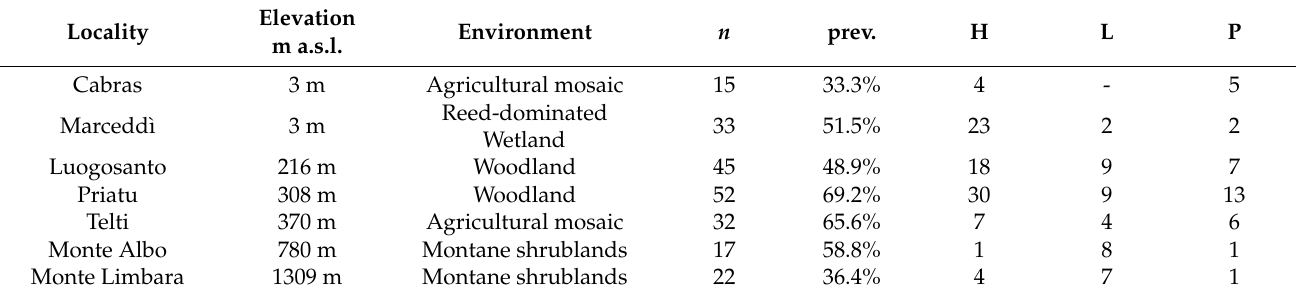
Table 2. Sampling localities with information about elevation, environmental features, number of sampled host individuals ( n ); overall haemosporidian prevalence (prev.); haplotypes number found for Haemoproteus (H), Leucocytozoon (L) and Plasmodium